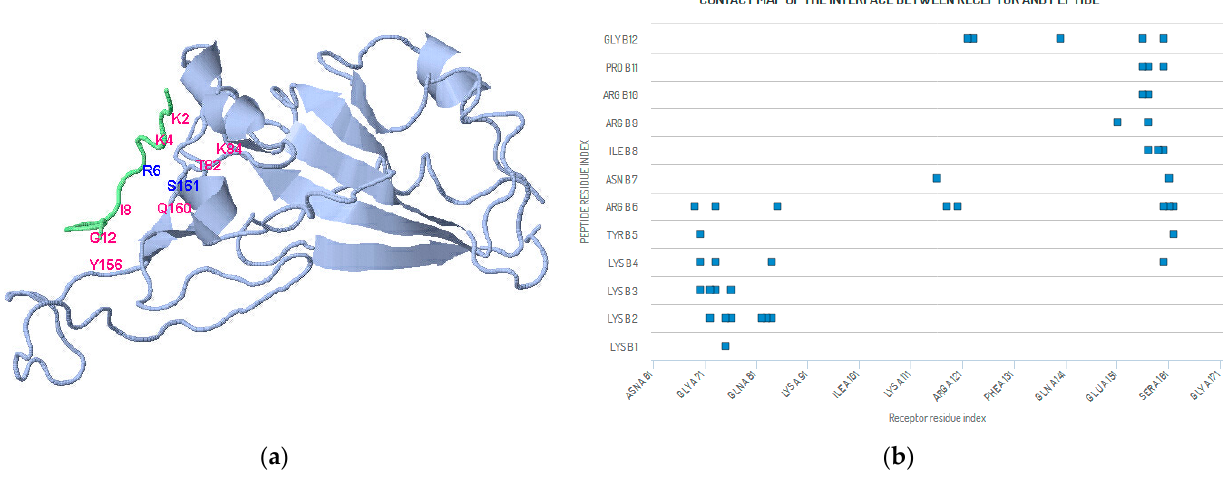
Figure 3. ( a ) Docking of peptide KKKKYRNIRRPG to RBD of S1 SARS-CoV-2 protein by means of CABS-dock server (Table S1: model 1) [28,75]. Pairs of peptide/receptor residuals shown in magenta or blue (3 ′ → 5 ′ antisense); ( b ) Contact map of the interface between peptide and receptor residues in a complex closer than 4.5 Å (Tables A2 and S1: model 1).